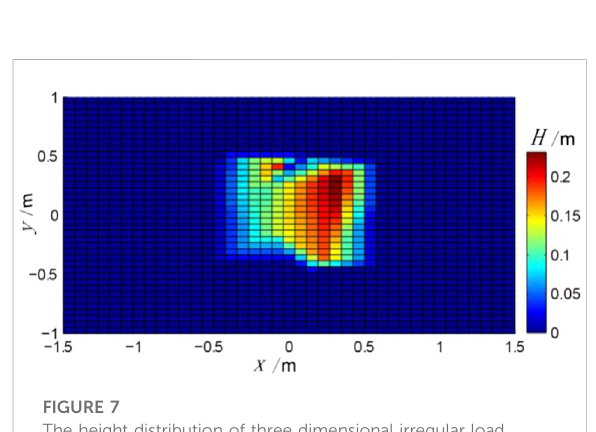
FIGURE 7 The height distribution of three dimensional irregular load